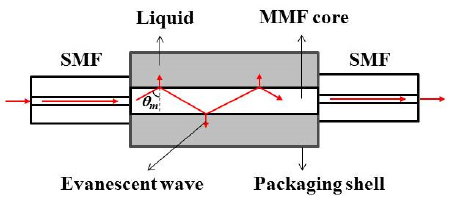
Figure 1. Schematic of SMS fiber structure.